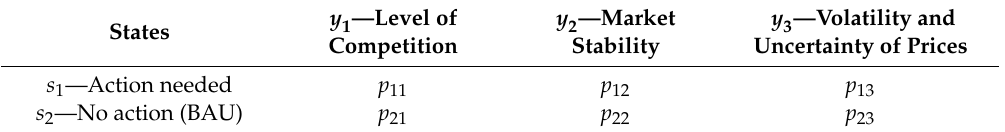
Table 3. Information structure conditional